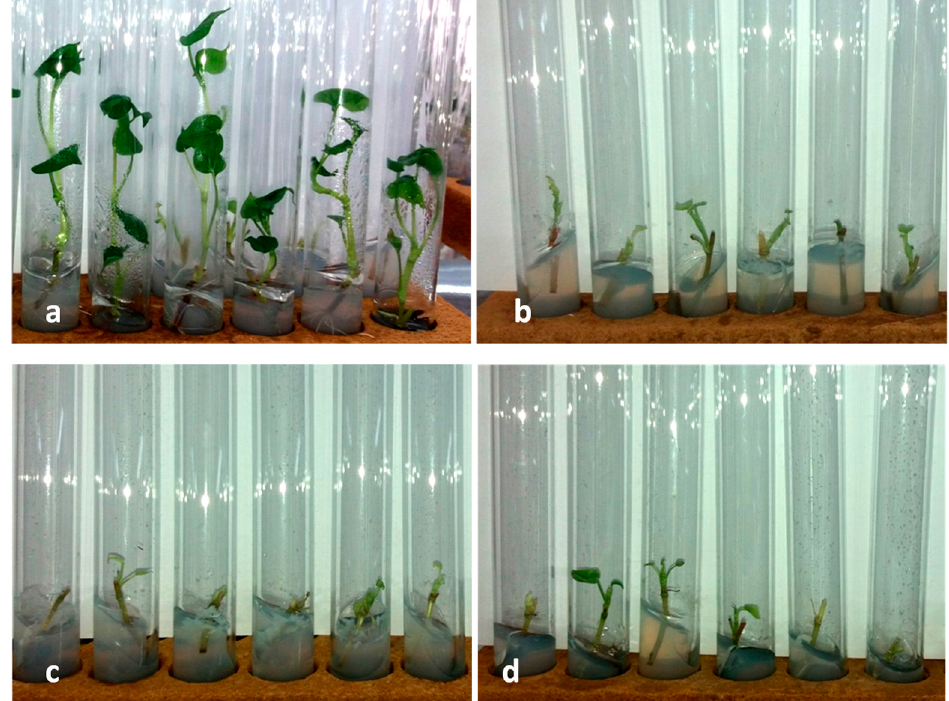
Figure 1. Effect of selective media with zinc on morphological indicators of buckwheat test tube regenerants of Izumrud (21-day cultivation): ( a ) control; ( b ) medium containing 808 mg L − 1 ZnSO 4 × 7H 2 O; ( c ) medium containing 1111 mg L − 1 ZnSO 4 × 7H 2 O; ( d ) medium containing 1313 mg L − 1 ZnSO 4 × 7H 2 O.